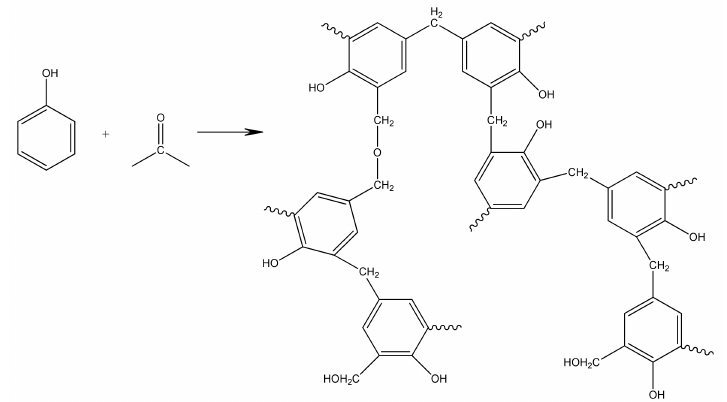
Figure 2. Polycondensation reaction of resorcinol with